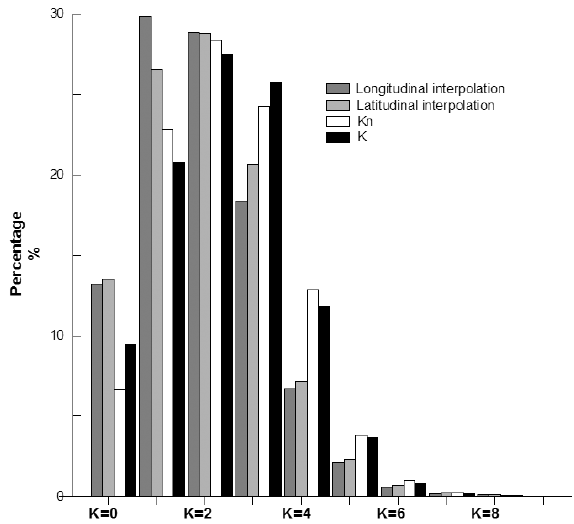
Figure 6. Comparison between the frequency distributions of K- real at Livingston (black bar), Kn calculated with the network (white bar) and Kp (grey bar).